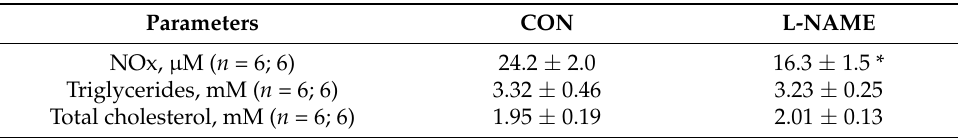
Figure 1. Characteristics of pregnant female rats in the control (CON) and L-NAME groups. ( a ) Body weight gain during the pregnancy. ( b ) Water consumption by dams in the control and L-NAME groups. ( c – d ) Systolic blood pressure (BP, c ) and heart rate ( d ) during the pregnancy, before (GD7), and during L-NAME treatment (GD15 and GD20); GD, gestation day; n , number of females. Data are presented as the mean ± S.E.M. * p < 0.05 compared to the control on the same day of pregnancy (unpaired Student’s t -test). Table 1. Serum parameters of control (CON) and L-NAME-treated